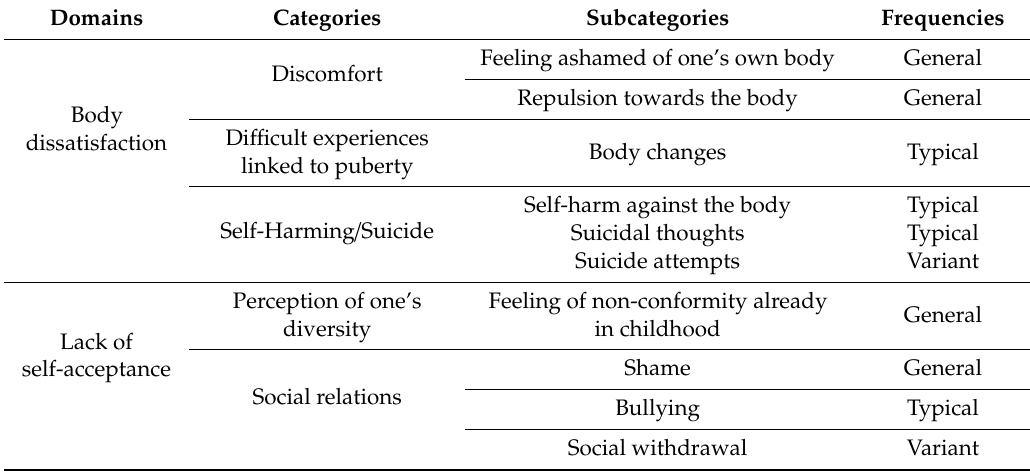
Table 2. Domains, categories and subcategories of the area Gender Identity: